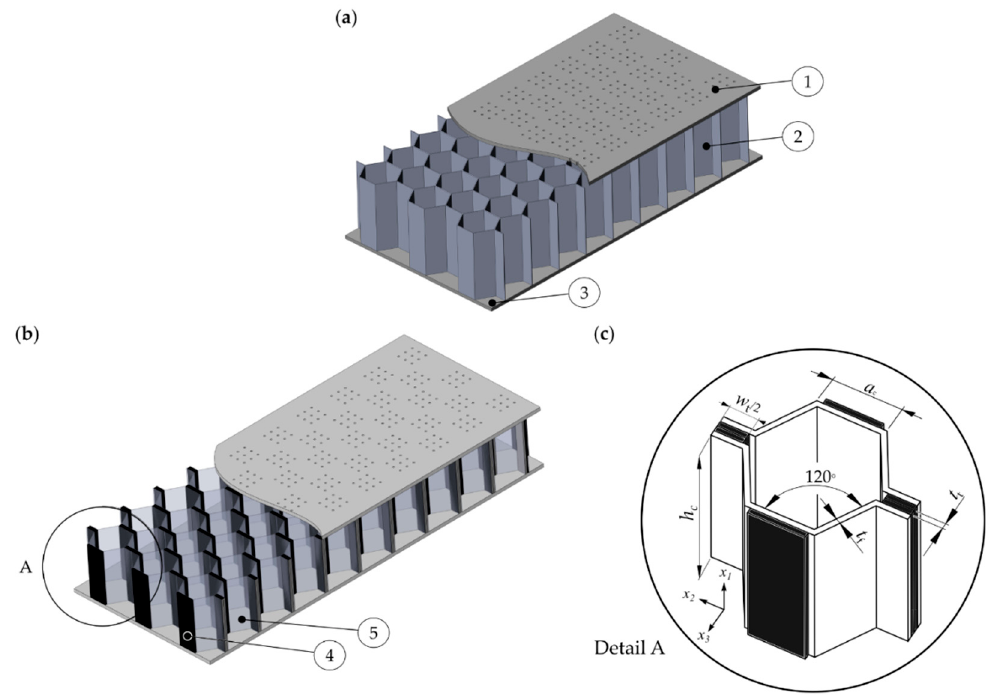
Figure 1. ( a ) Conventional Helmholtz resonator liner with perforated upper layer (1), cell core (2), and bottom layer (3), ( b ) new concept of a hybrid acoustic liner with fiber-reinforced tape (4) and flexible cell wall (5) and ( c ) detail of the hybrid cell core structure.